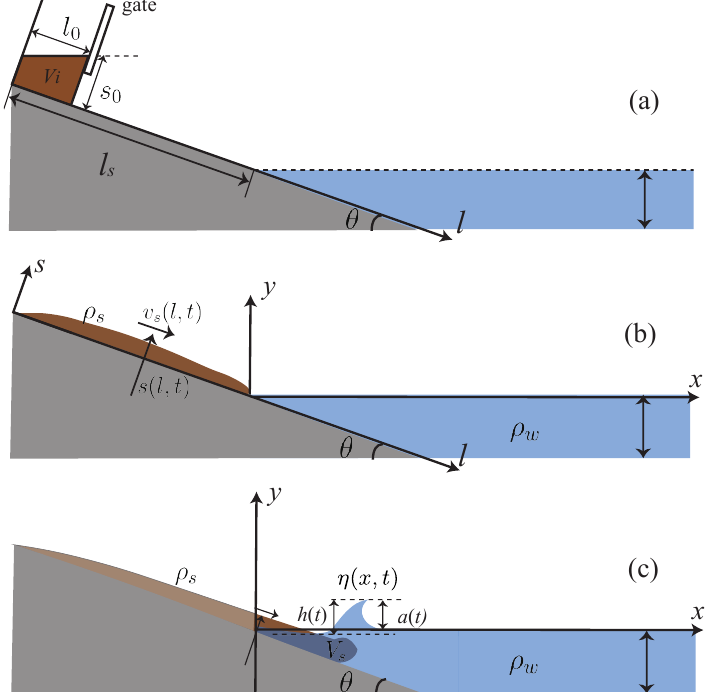
Figure 1. Two dimensional physical model of a landslide generating wave: ( a ) the slide material is at rest and then starts moving (stage I), ( b ) the slide material moves down the slope and reaches the shoreline (stage II), and ( c ) the slide material intrudes into the body of water and generates waves (stage